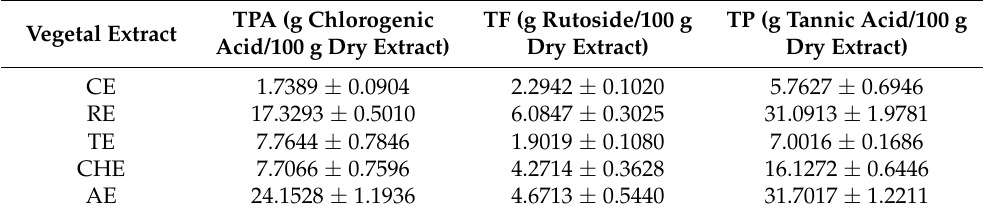
Table 1. Quantitative analysis of active compounds in vegetal extracts. Vegetal